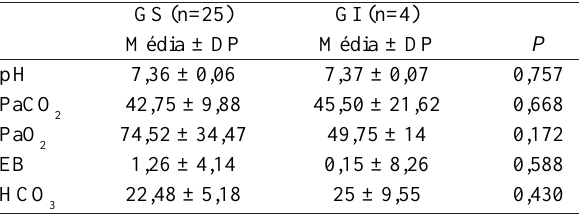
Tabela 3. Valores gasométricos nas crianças em pós-operatório de cardiopatias